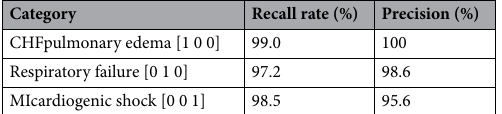
Table 4. Pulse classification recognition rate of EPNCC-CNN.